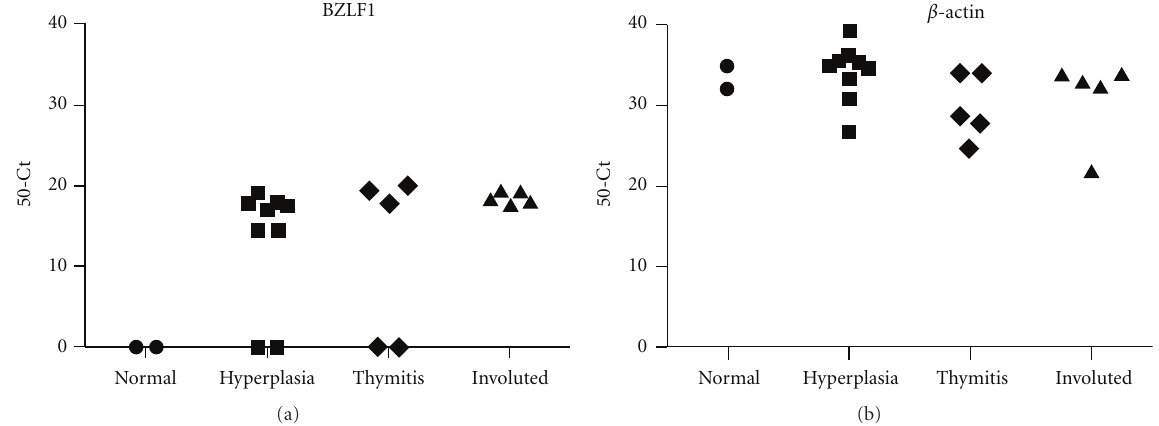
Figure 5: Real-time RT-PCR for the detection of lytic BZLF1 transcript. (a) Real-time RT-PCR for BZLF1 could detect the lytic transcript in 7/9 hyperplastic thymuses, 3/5 thymitis, and 5/5 involuted thymuses, but not in normal control thymuses. (b) All MG and control thymuses analysed showed high signals for endogenous control β -actin